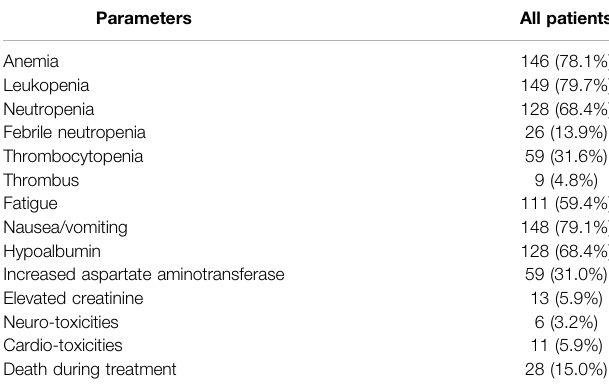
TABLE 4 | Multivariate analysis of PFS in patients with DLBCL (n=239).